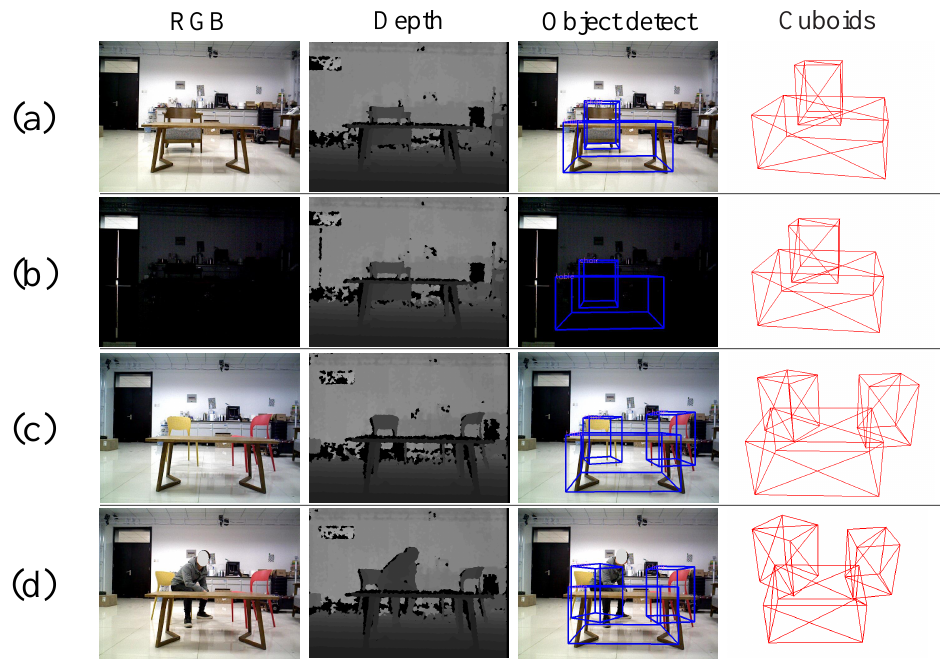
Figure 8. Four examples of 3D object detection results in real-world environments. ( a , b ) are the detection comparison results of the illumination variation. ( c , d ) are the comparison results of detection of occlusion and a dynamic object. Experimental results indicate that the proposed high-dimensional semantic-geometric features have high